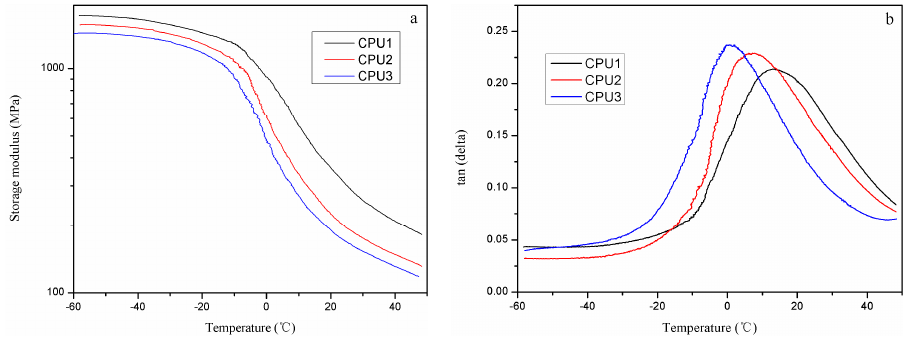
Figure 3. Dependences of storage modulus ( a ) and tan delta ( b ) on temperature for CPUs.